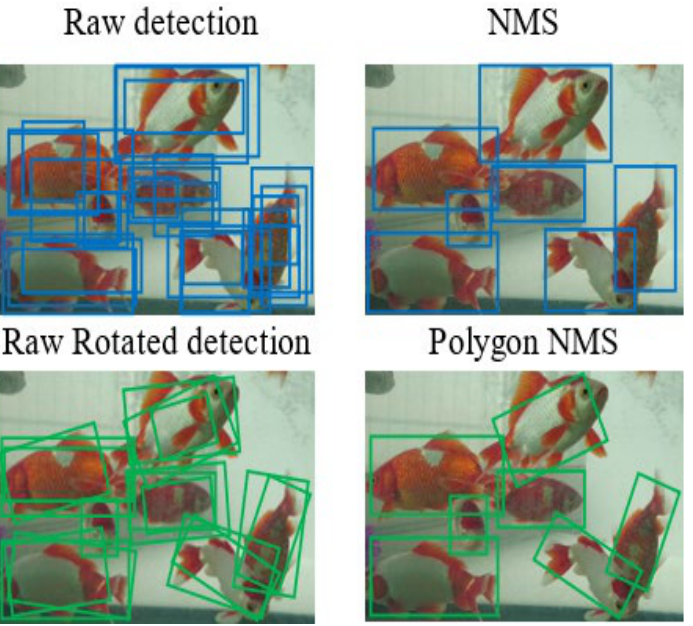
Figure 8. The upper left picture is the raw picture after detection, and the upper right picture was obtained after the NMS operation. The bottom left is the picture that was detected by the rotating box, and the bottom right picture was obtained after the operation of Polygon NMS.